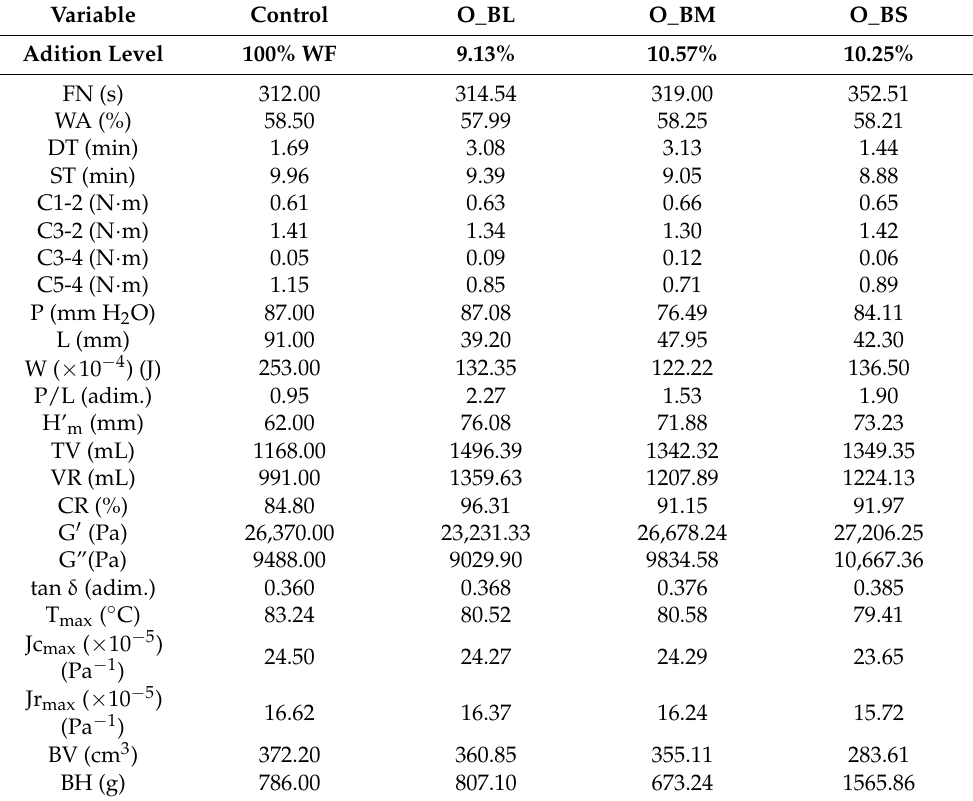
Table 4. Wheat flour dough and optimized composite flour for each buckwheat flour particle